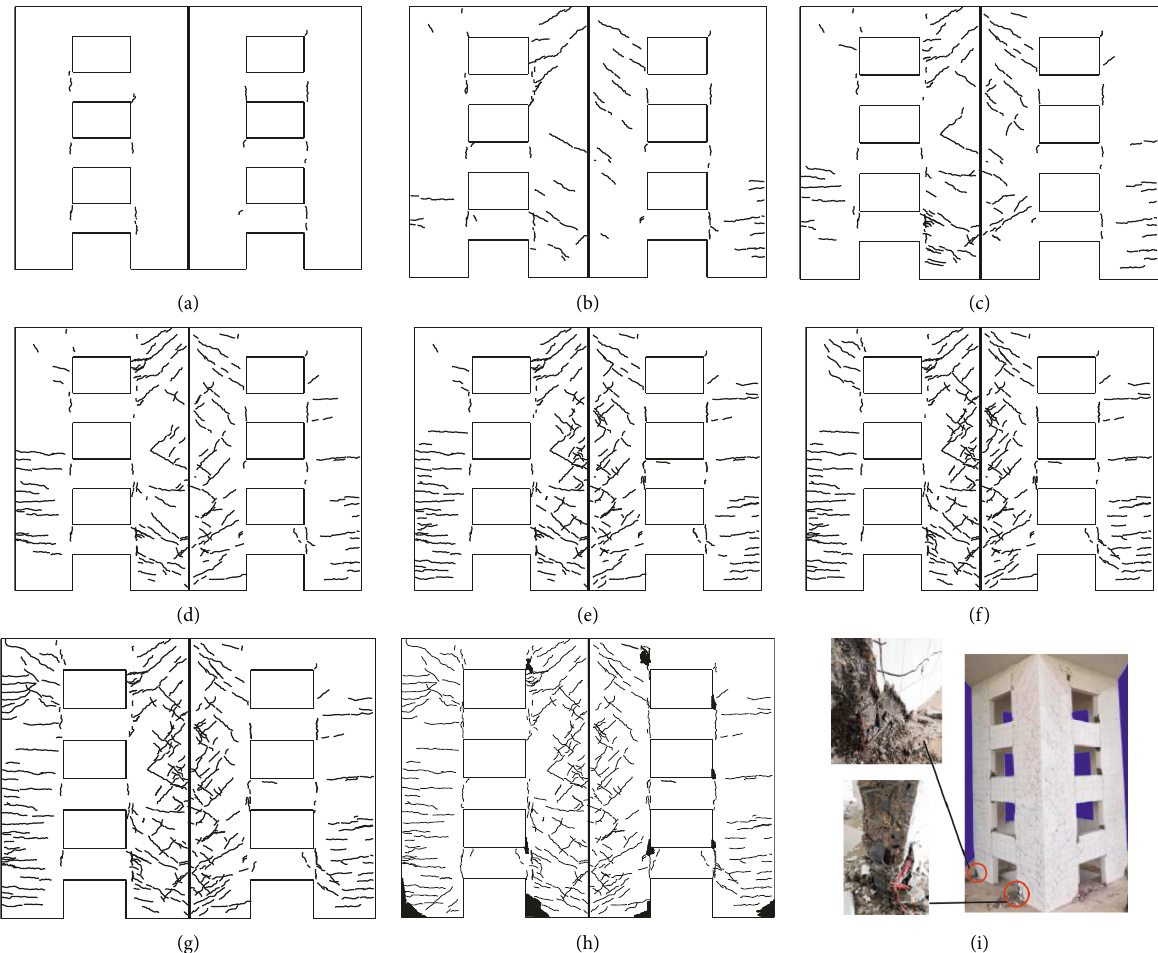
Figure 6: Destruction process of specimen CW4X-D. (a) θ � ± 0.125%. (b) θ � ± 0.25%. (c) θ � ± 0.5%. (d) θ � ± 0.75%. (e) θ � ± 1%. (f) θ � ± 1.32%. (g) θ � ± 1.69%. (h) Final stage. (i) Failure